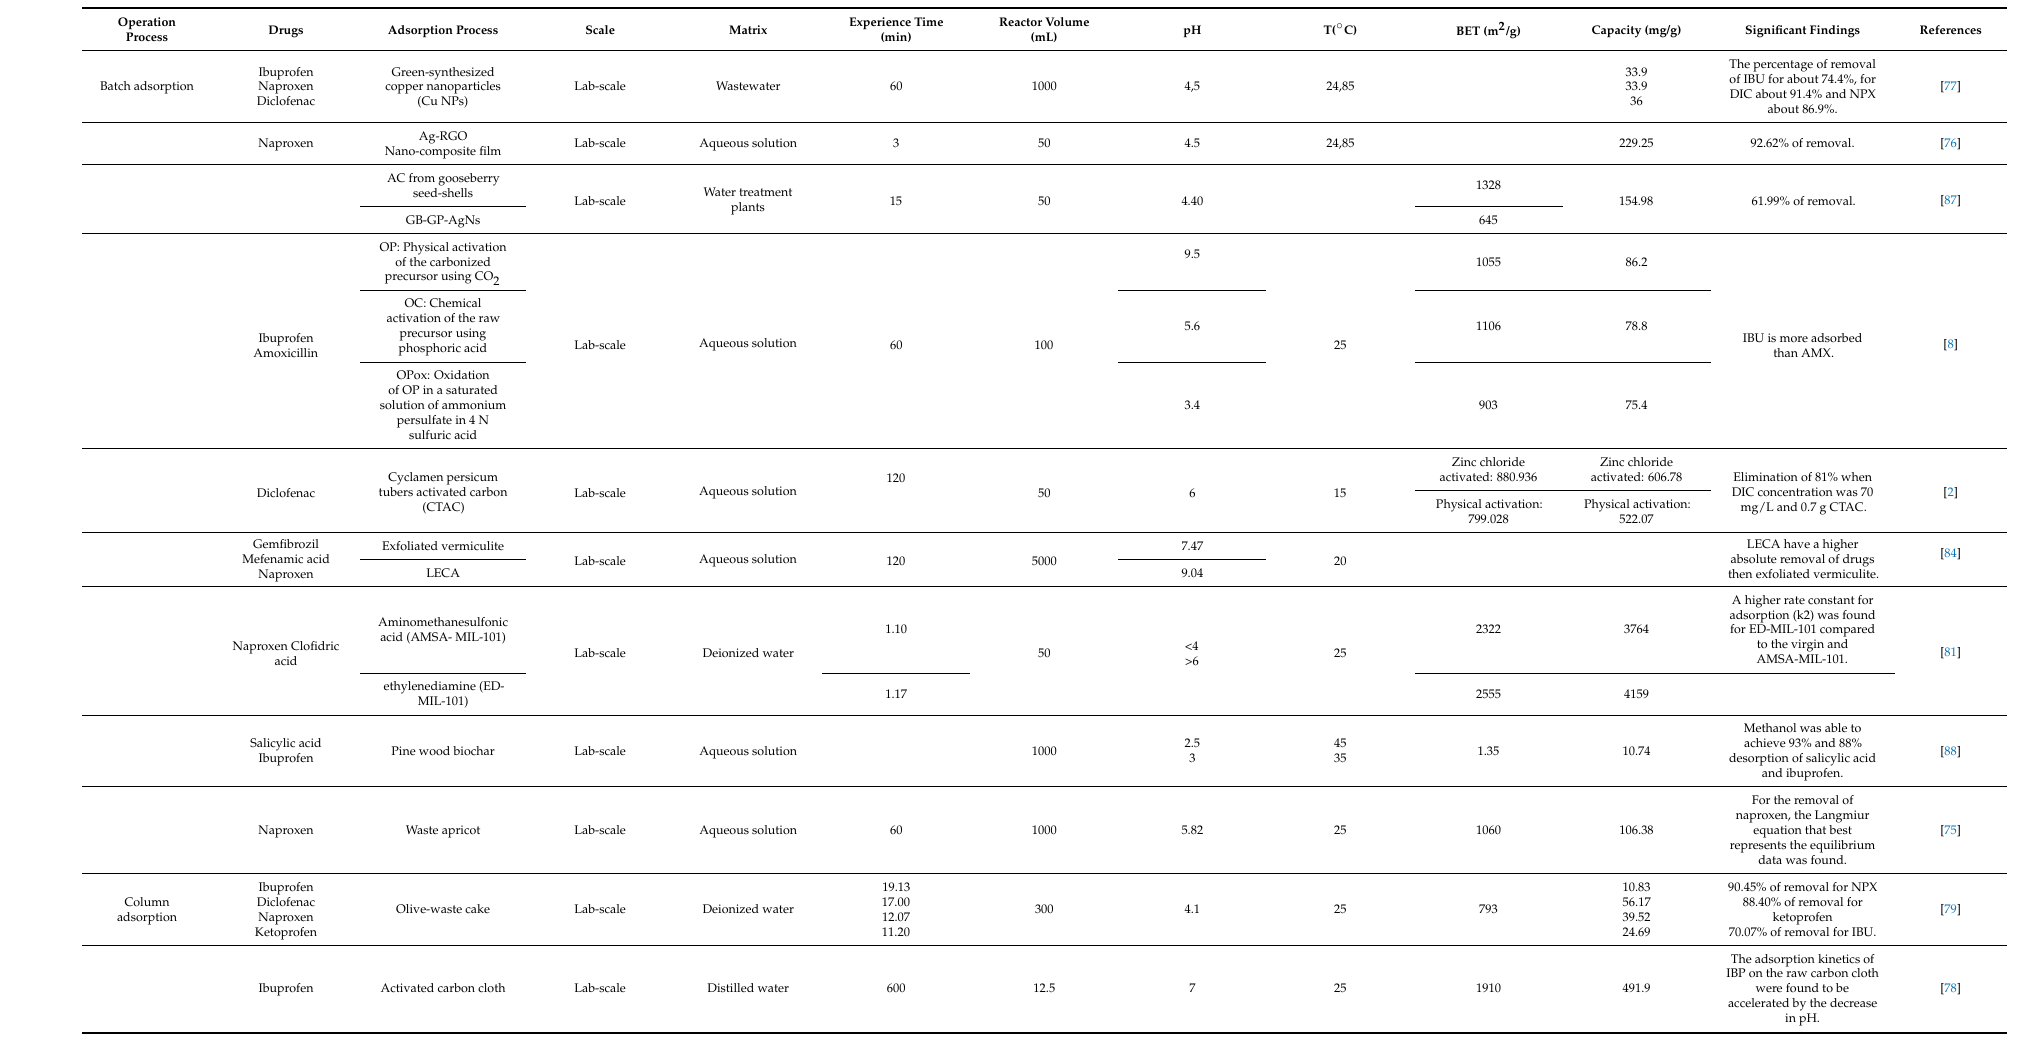
Table 2. Removal of pharmaceutical products by adsorption